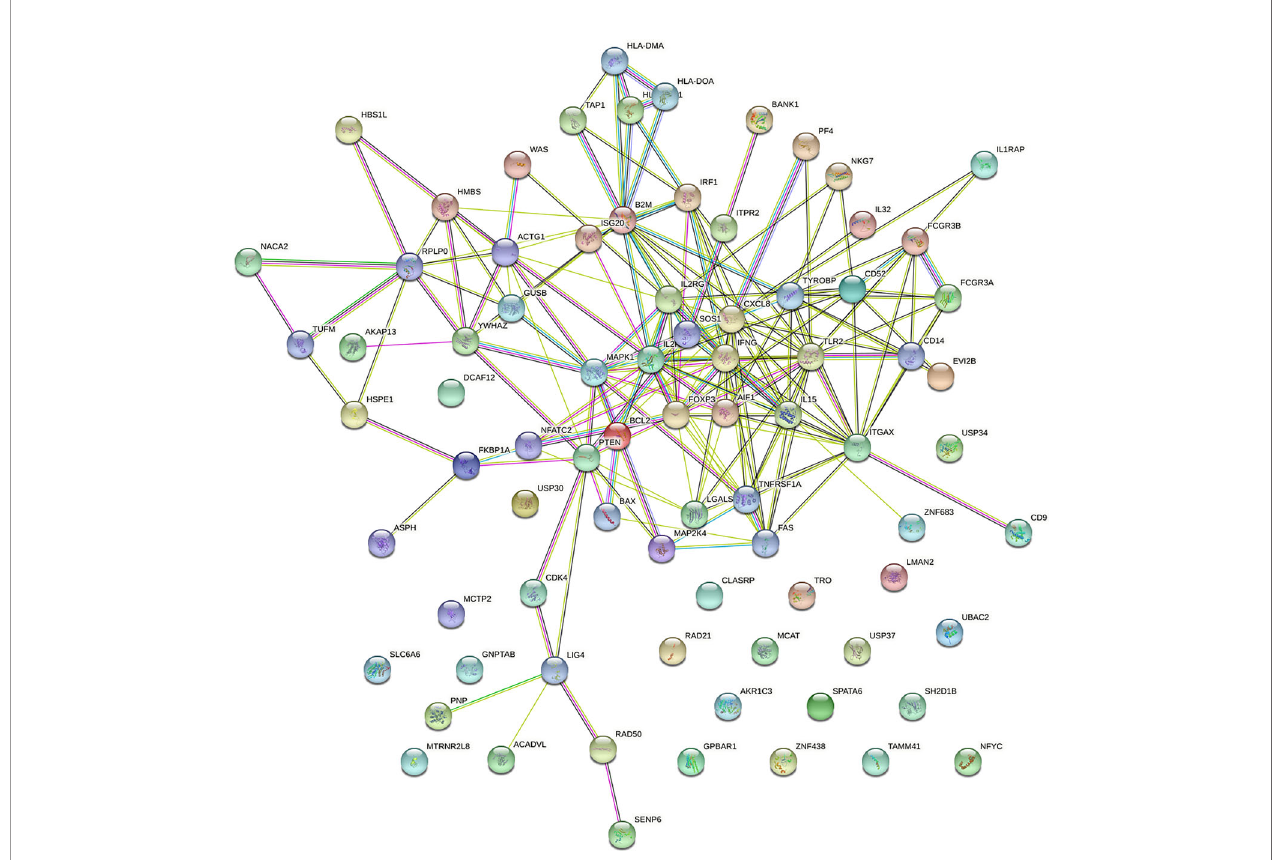
FIGURE 2 | Protein – protein interaction (PPI) network of the dysregulated